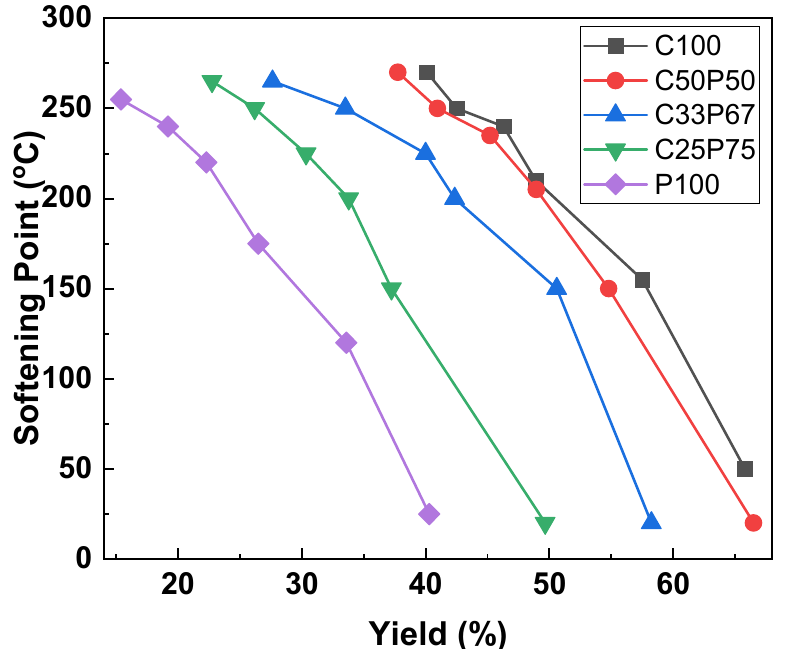
Figure 3. Softening point and yield changes of spinnable pitches prepared by co-carbonization of purified coal tar pitch and PFO in various ratios.